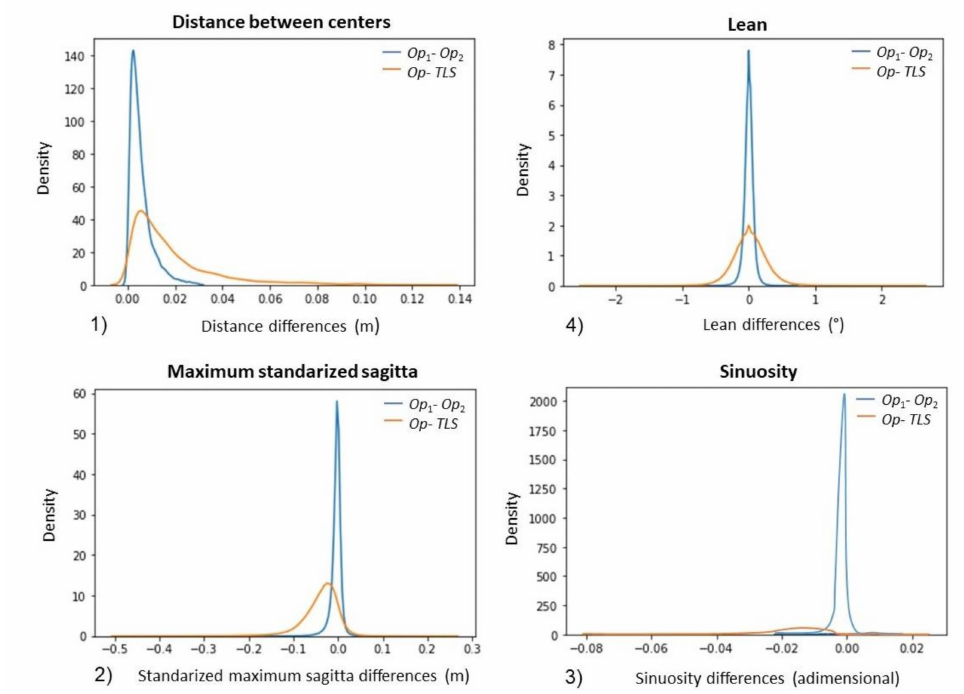
Figure 8. Probability density functions of the error transmission from the centers of the sections to the shape variables as follows: ( 1 ) Distance between centers, ( 2 ) maximum standardized sagitta ( SS max ), ( 3 ) sinuosity, ( 4 ) lean.